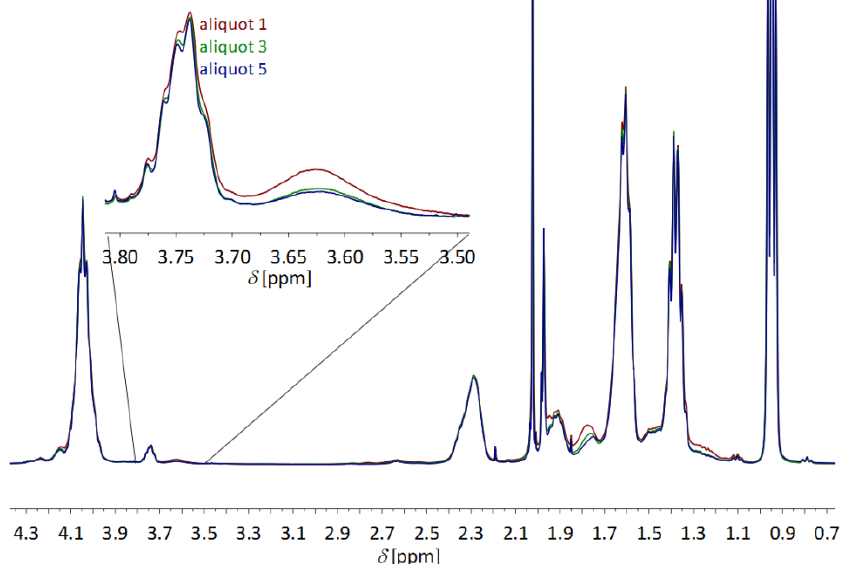
Figure 15. Superimposed, standardized 1 H NMR spectra measured in CDCl third and fifth aliquot of a copolymerization of BA and 1.1 using 5000 mmol·L − 1